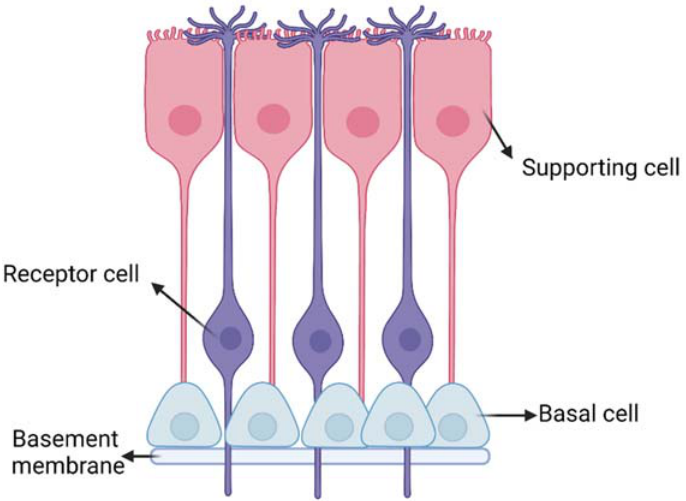
Figure 3. Schematic representation of the olfactory epithelium with the three main cells: (i) the olfactory receptor cells provided with non-motile cilia; (ii) the supporting cells and (iii) the basal cells. Created with BioRender.com.